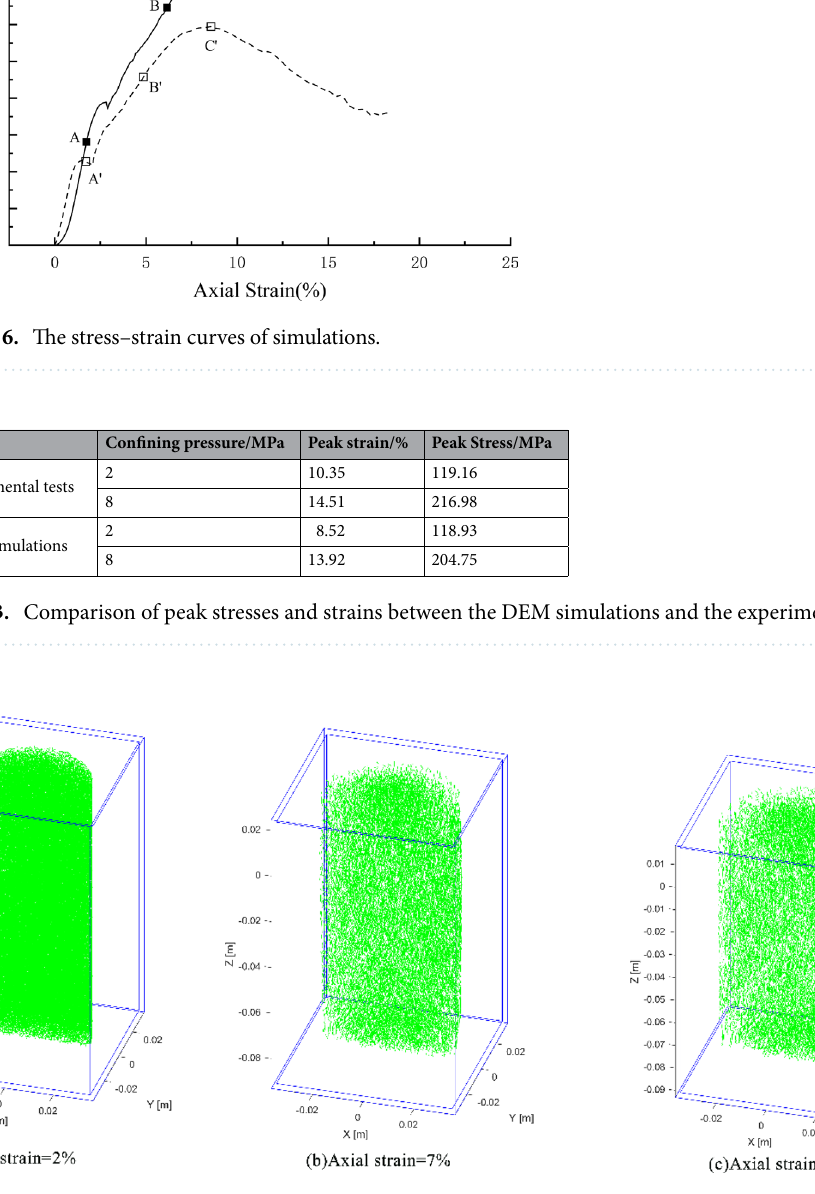
Figure 7. The micro connections of the model under 8 MPa confining pressure (segments indicate intact